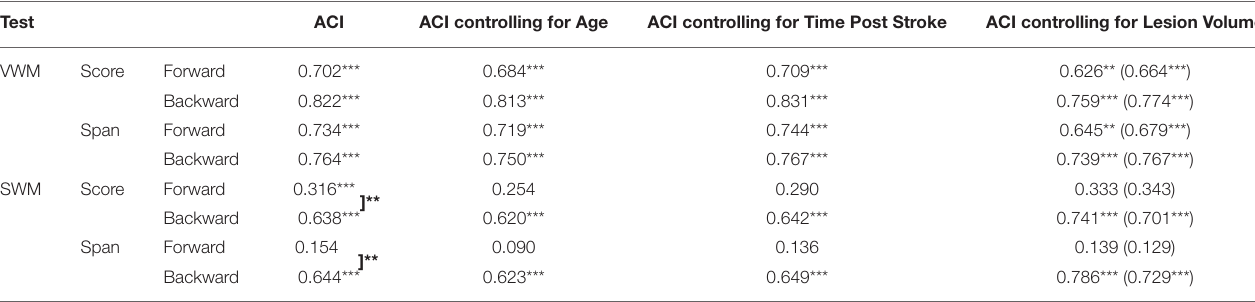
Test ACI ACI controlling for Age ACI controlling for Time Post Stroke ACI controlling for Lesion